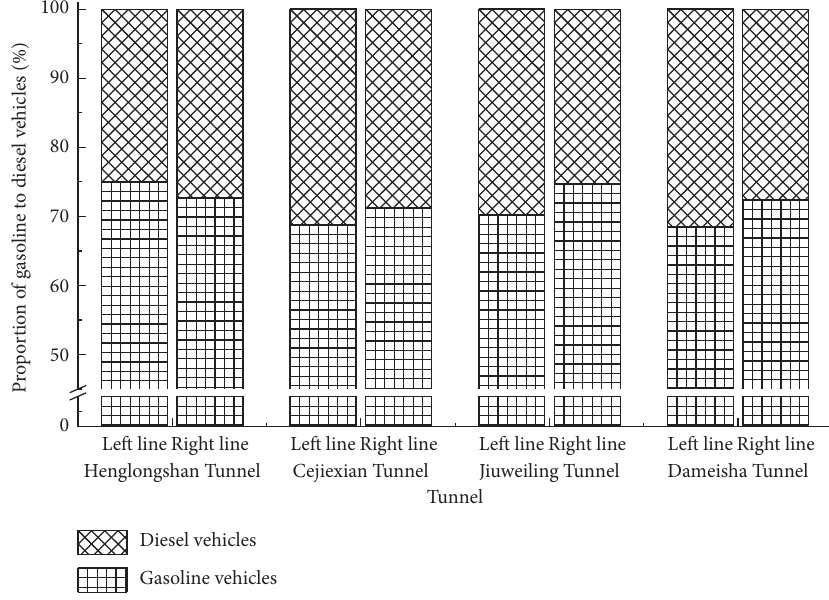
Figure 5: Proportion of gasoline to diesel vehicles in the four tunnels. Table 3: Meteorological parameters in the four tunnels.